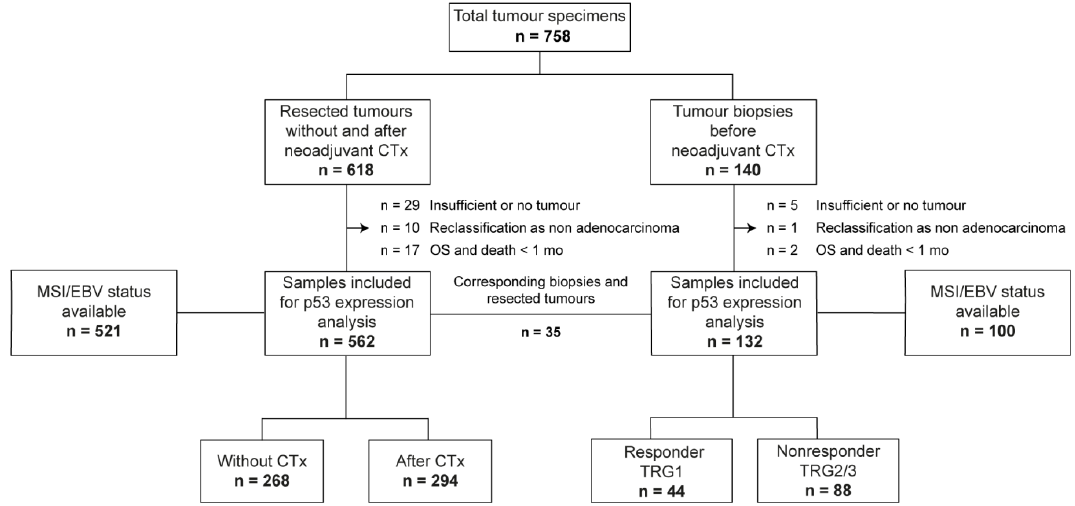
Figure 1. Flow chart diagram of patients and specimens inclusion. OS, Overall survival; TRG, tumor regression grade; CTx, chemotherapy; OS, overall survival; mo, months; EBV, Epstein–Barr virus; MSI, microsatellite instability. Table 1. Patient characteristics. Resection Specimens Tumor Biopsies Before Neoadjuvant